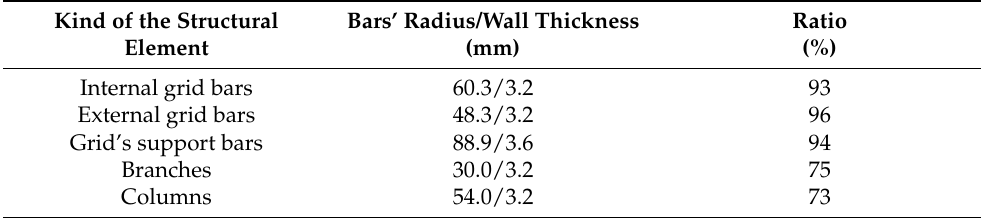
Table A4. Structural analysis results of structure 3b performed by Robot Structural Analysis Profes- sional software. Kind of the